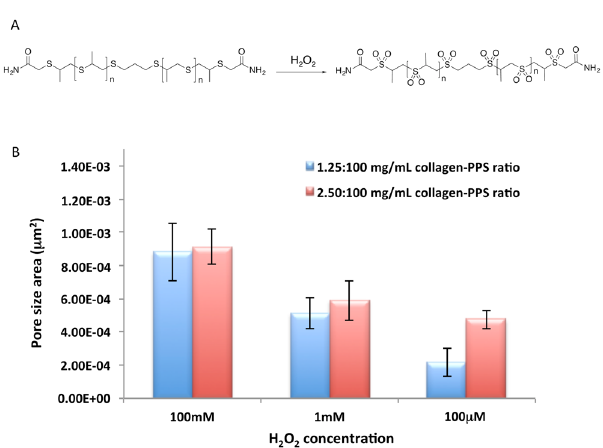
Figure 5. SEM imaging of ROS-responsive hollow spheres. 1 μ m collagen-PPS hollow spheres before ( A ), and after (B) 72 hours exposure to H 2 O 2 ( B ). Control: collagen-dithiolPEG hollow spheres before ( C ), and after ( D ) 72 hours exposure to H